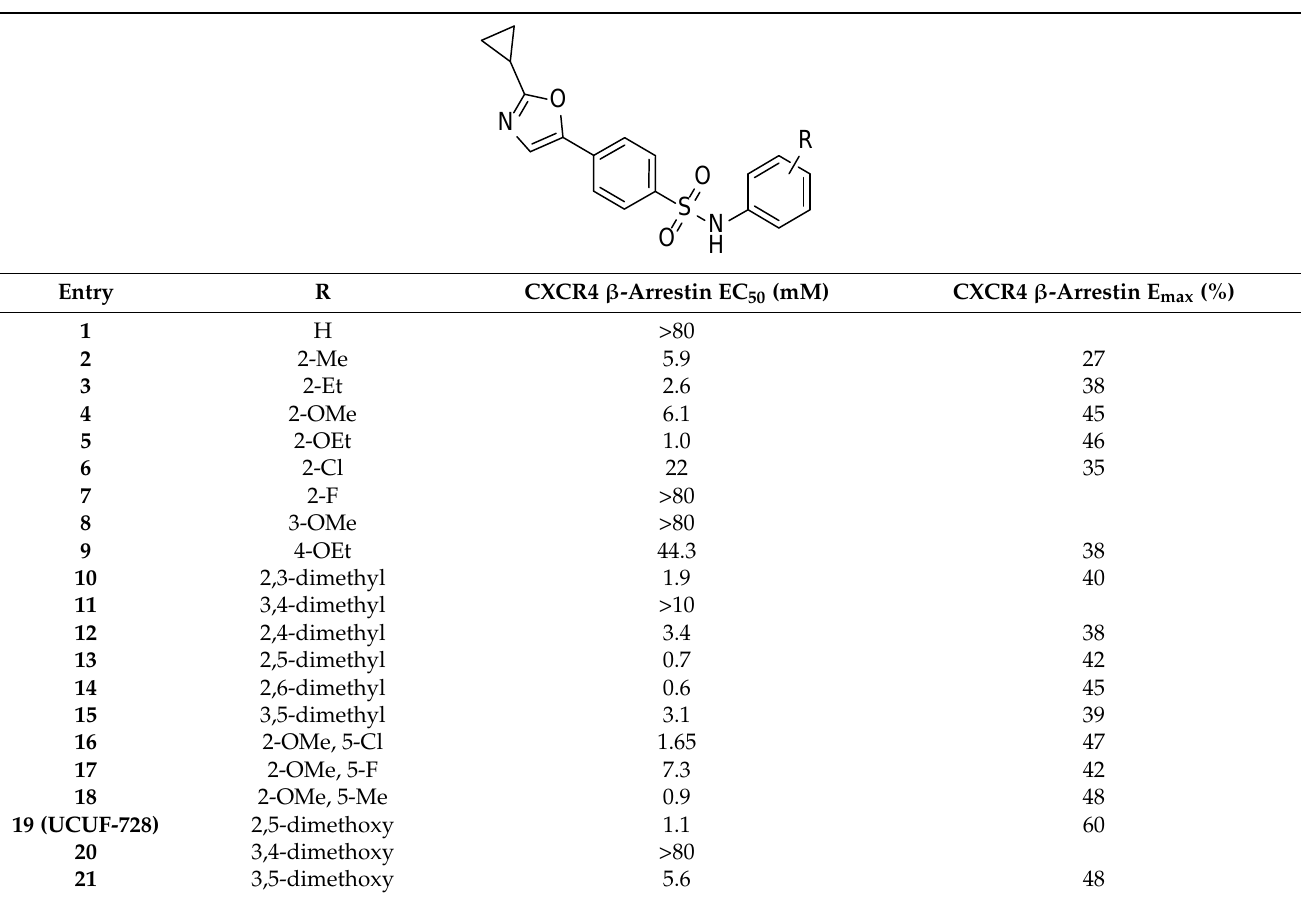
Table 1. SAR of analogs of the 5-aryl-2-cyclopropyloxazole series in the primary CXCR4 b-arrestin recruitment assay.